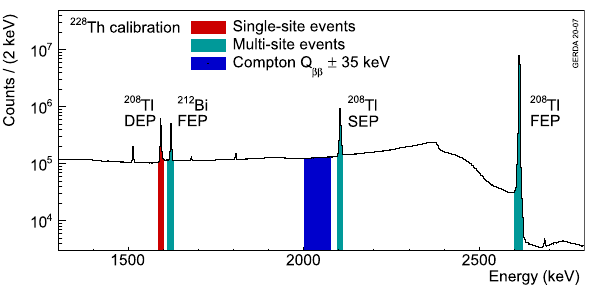
Fig. 4 Calibration spectrum highlighting the different event samples used in the pulse shape analysis